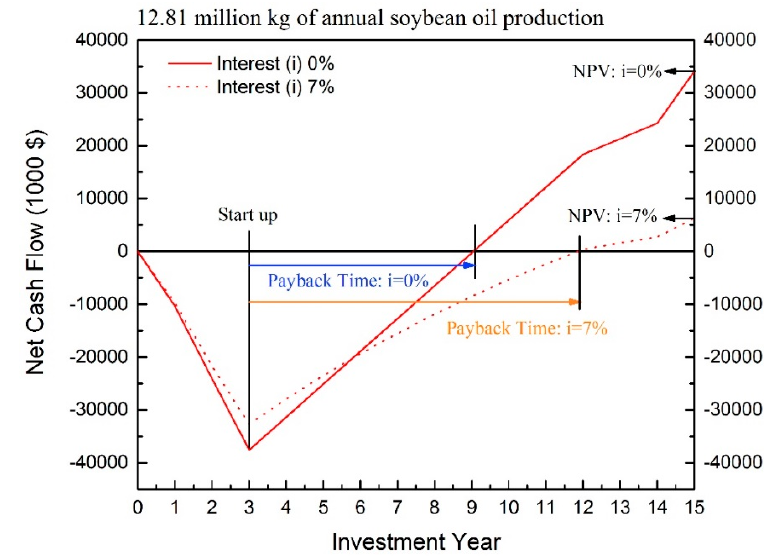
Figure 3. The profile of cash flow.